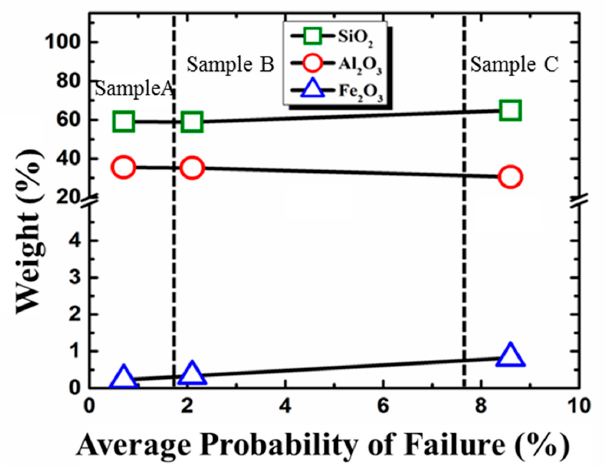
Figure 8. Probability of failure of samples A, B, and C based on the weight percentage of the porcelain